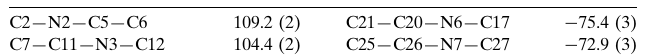
Selected torsion angles ( (cid:1)